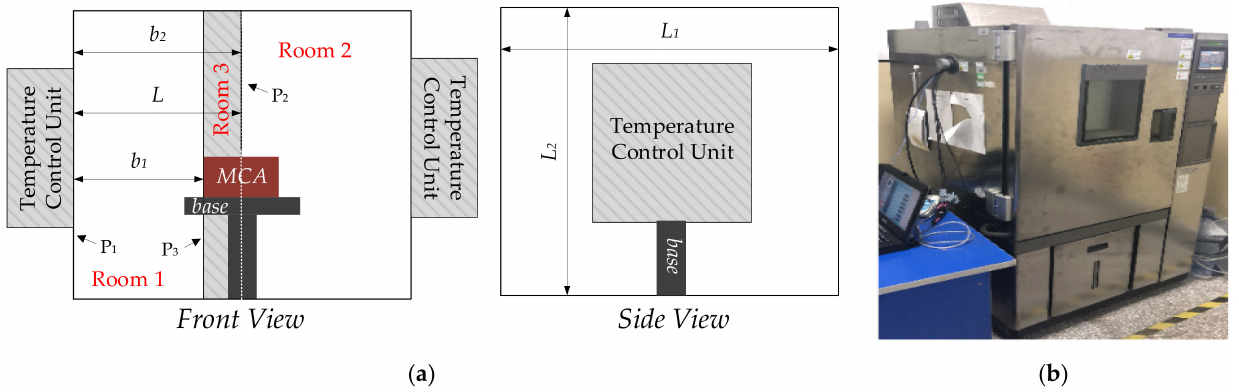
Figure 5. The schematic diagram of test platform. ( a ) The installation of MEMS accelerometer inside the thermal chamber; ( b ) field test of TDE test